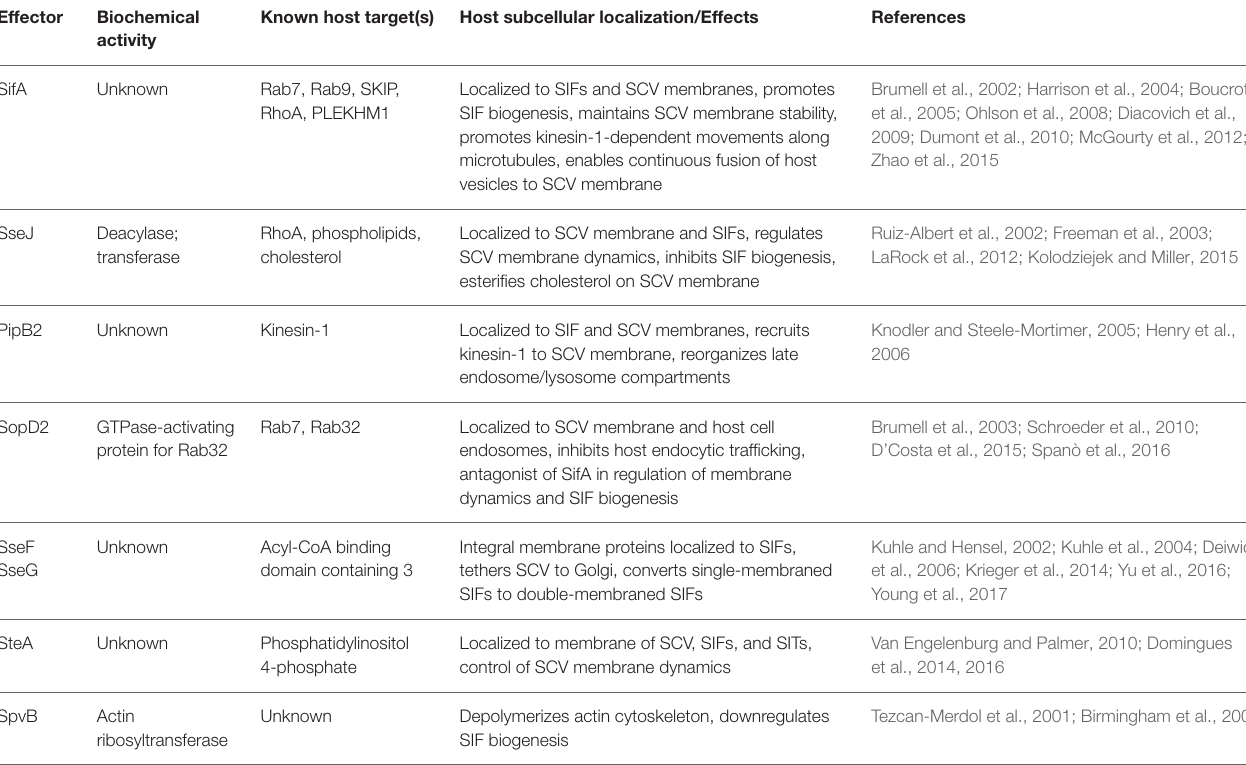
TABLE 1 | SPI2-T3SS secreted effectors associated with SCV maturation and SIF